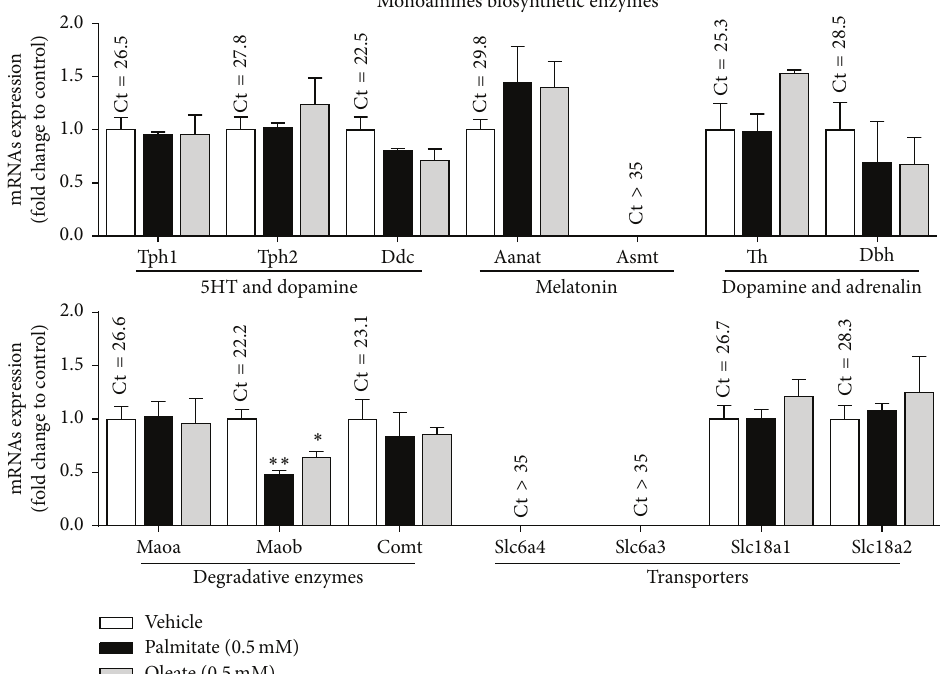
Figure 4: mRNA expression of monoamines-related genes in NEFAs-treated MIN6 𝛽 -cells. MIN6 𝛽 -cells were treated during twenty-four hours with palmitate or oleate (0.5mM). Then, total RNA was extracted and mRNA levels of genes related to the monoamines biosynthesis, degradation, and transport were evaluated by RT-qPCR. The mRNA levels are expressed as fold change between 2 −Δ Ct of the specific gene in the treated versus control conditions (see Section 2). Graph bars represent mean ± standard errors of measurements of three independent experiments in triplicate. The numbers above bars represent the mean Ct value in control cells. The symbol ∗ denotes 𝑝 < 0.05 and ∗∗ denotes 𝑝 < 0.01 in one-way